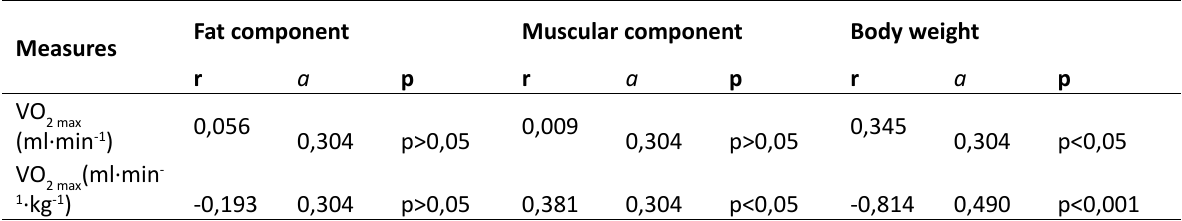
Table 3. Interrelation of the maximum oxygen consumption of with body weight and body component structure of women (endomorphic somatotype)